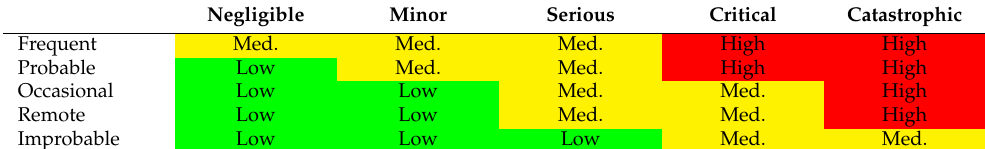
Table 3. Risk matrix example based on quantitative probability and qualitative severity [45]. Negligible Minor Serious Critical Catastrophic Frequent Med. Med. Med. High High Probable Low Med. Med. High High Occasional Med. Med. High